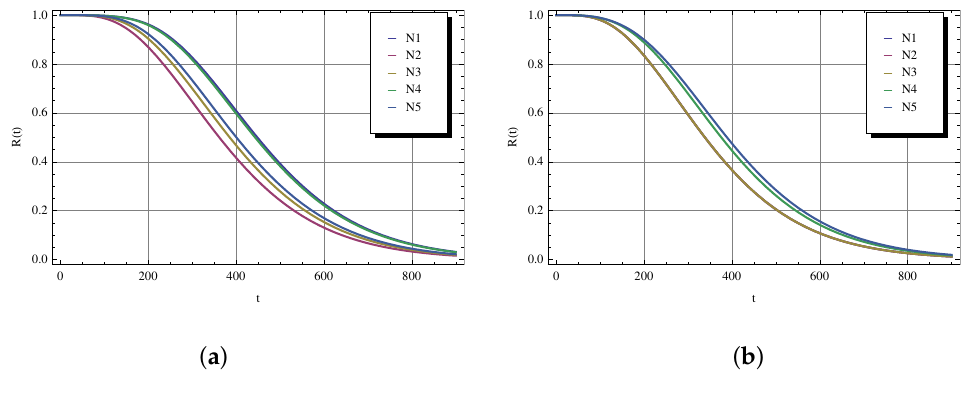
Figure 6. R ( t ) for ν = 0.001 ( a ) and ν = 0.005 ( b